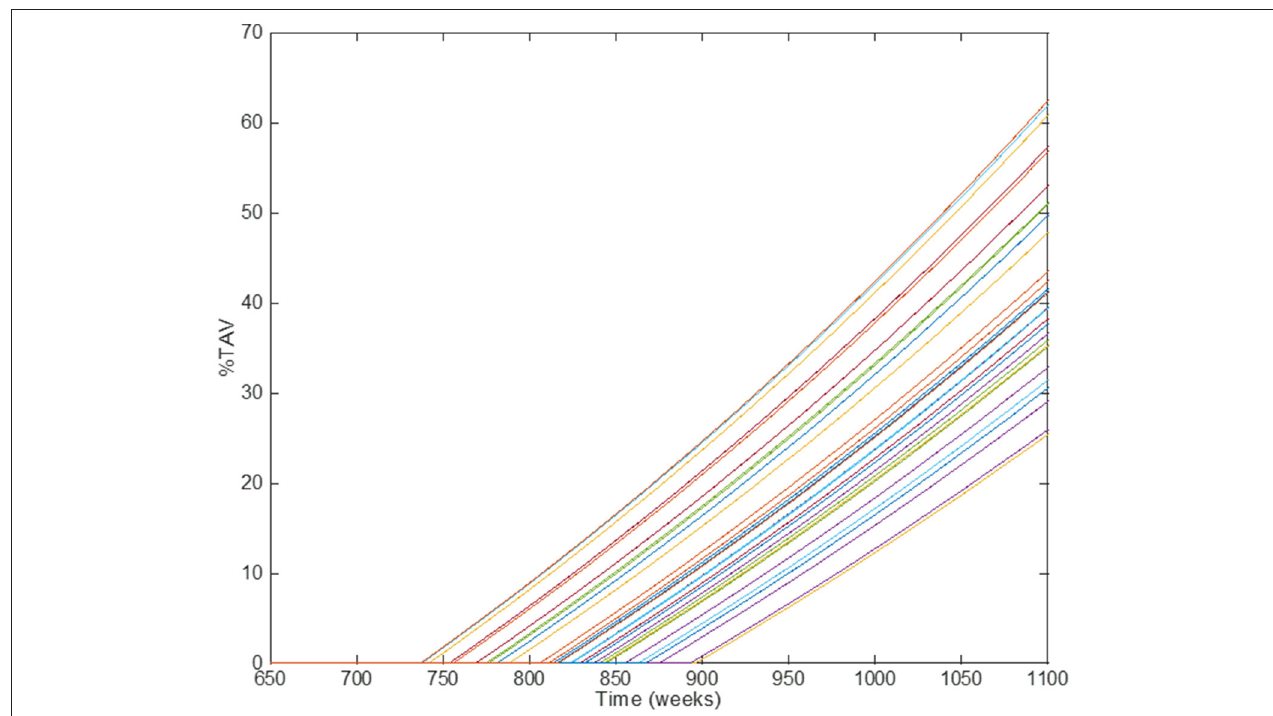
FIGURE 8 | Comparison of simulation results using different individual parameters in the original physical–based model of atherosclerosis. Different lines show the results of individual patients’ trajectories (plaque growth for individual patients); the time when the plaque starts to growth (time for transition) can be different for different